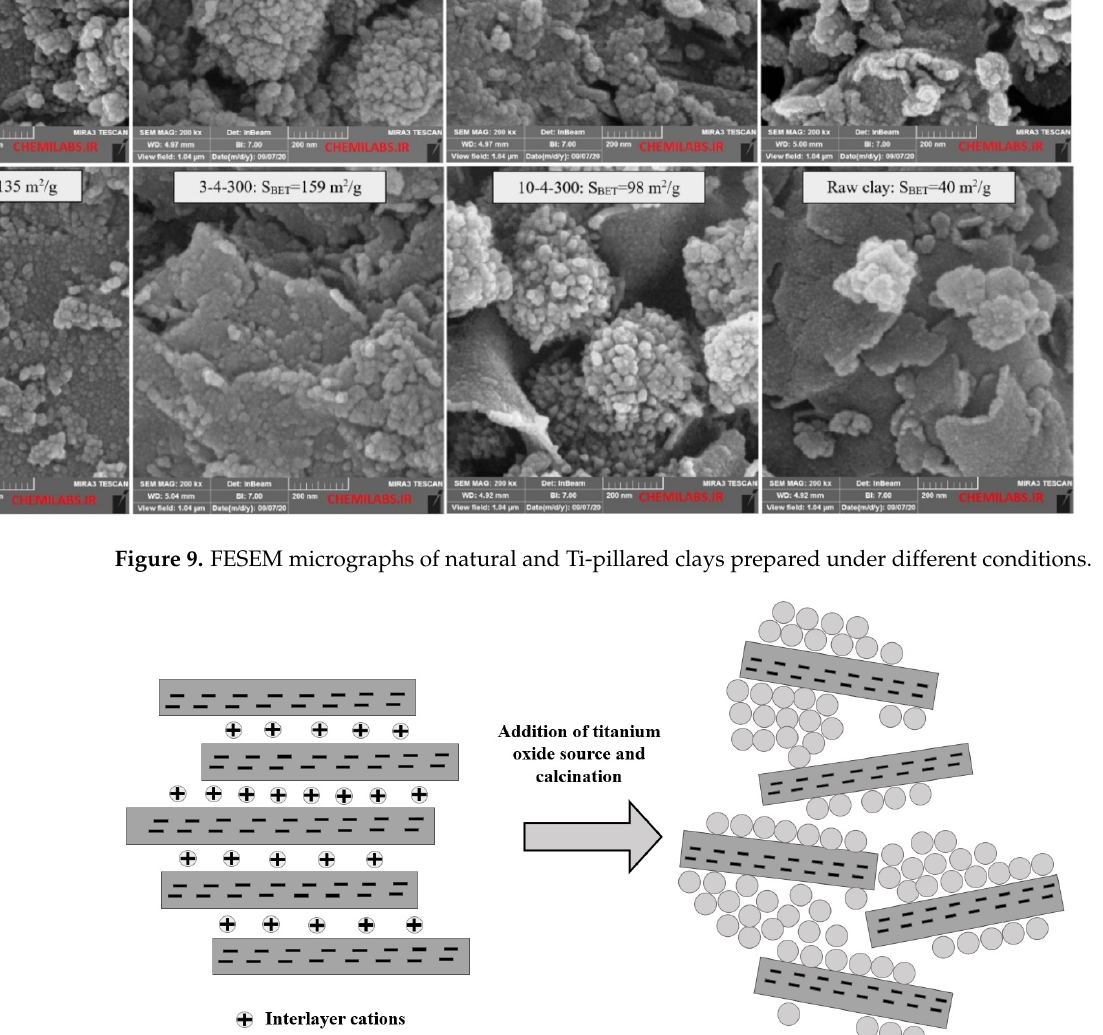
Figure 11. Low-angle X-ray diffraction and basal spacing of the raw clay and Ti-PILC (0.5-6-300). The normal XRD patterns of the Ti-PILC samples compared with the raw clay at large angles (2 θ = 10–60°) are also shown in Figure 12. The presence of quartz (Q) and montmo- rillonite (M) was determined by detecting several peaks in the XRD pattern of the raw 1